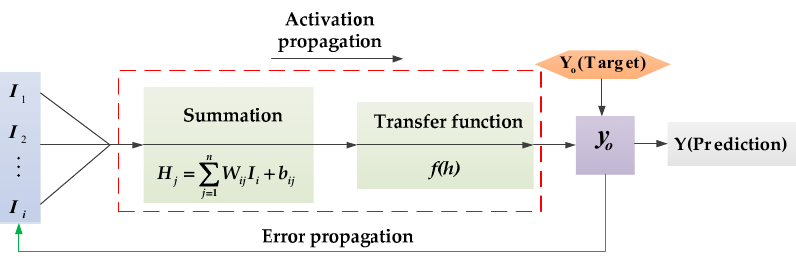
Figure 6. The basic neuron in the hidden layers in the feedback phase.